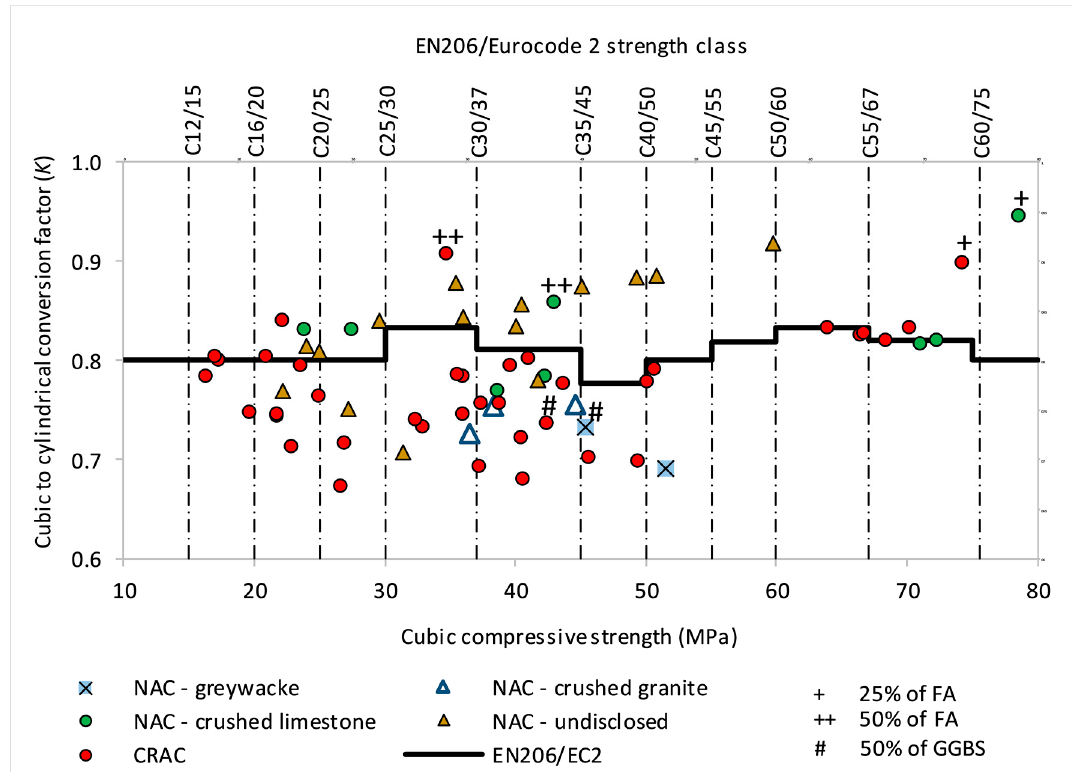
Figure 1. K versus cubic compressive strength.